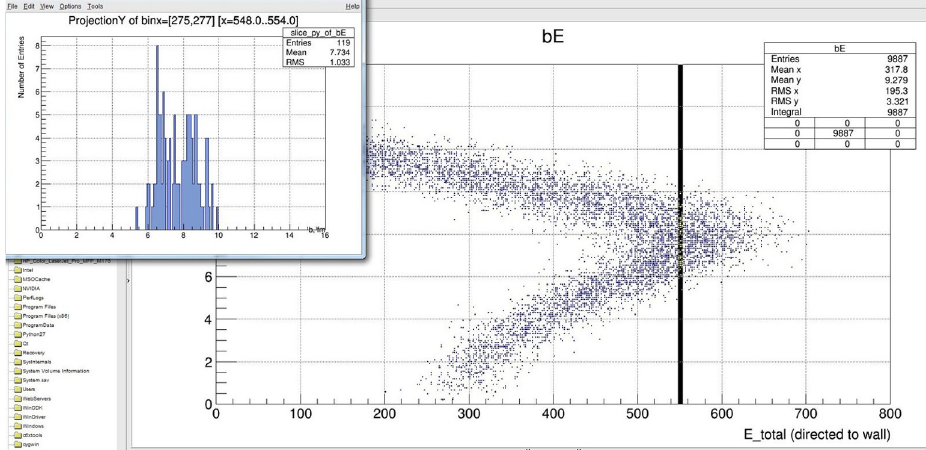
Figure 6. 6 Impact parameter distribution for fixed value 550 MeV absorbed in the calorimeter